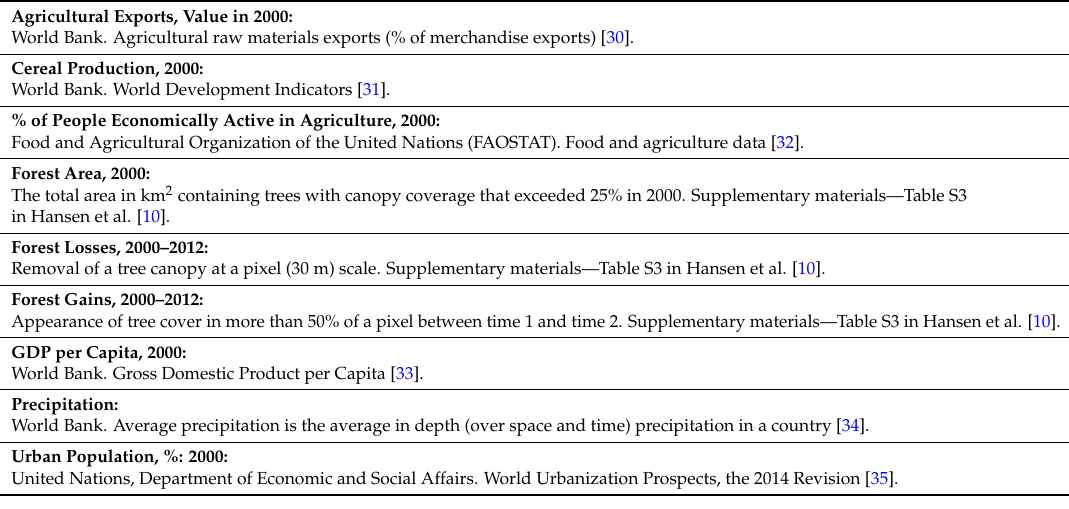
Table 1. Data Sources for Variables in Tables 2 and 3.